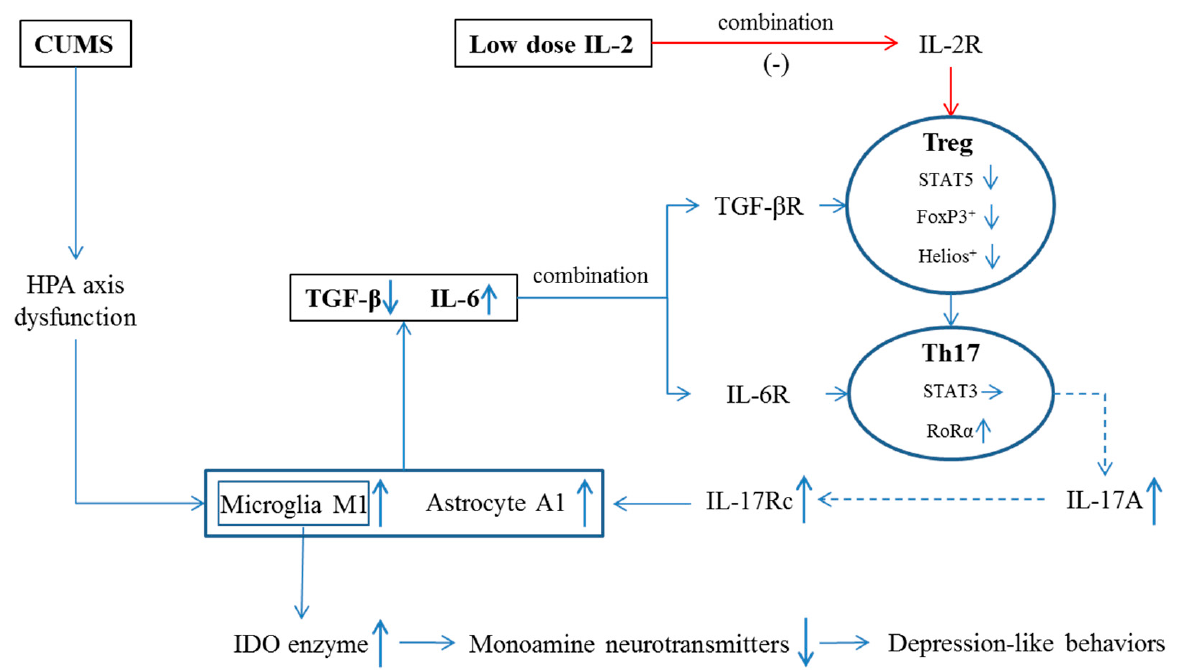
Figure 1. Possible mechanism by which low-dose IL-2 reversed CUMS-induced depression-like changes. IL-2R, interleukin-2 receptor; TGF- β R, transforming growth factor- β receptor; IL-6R, IL-6 receptor, IL-17Rc, IL-17 receptor c; ↑ , level was increased; ↓ , level was decreased; → , level was unchanged; solid line, known evidence; dotted line, hypothesis.